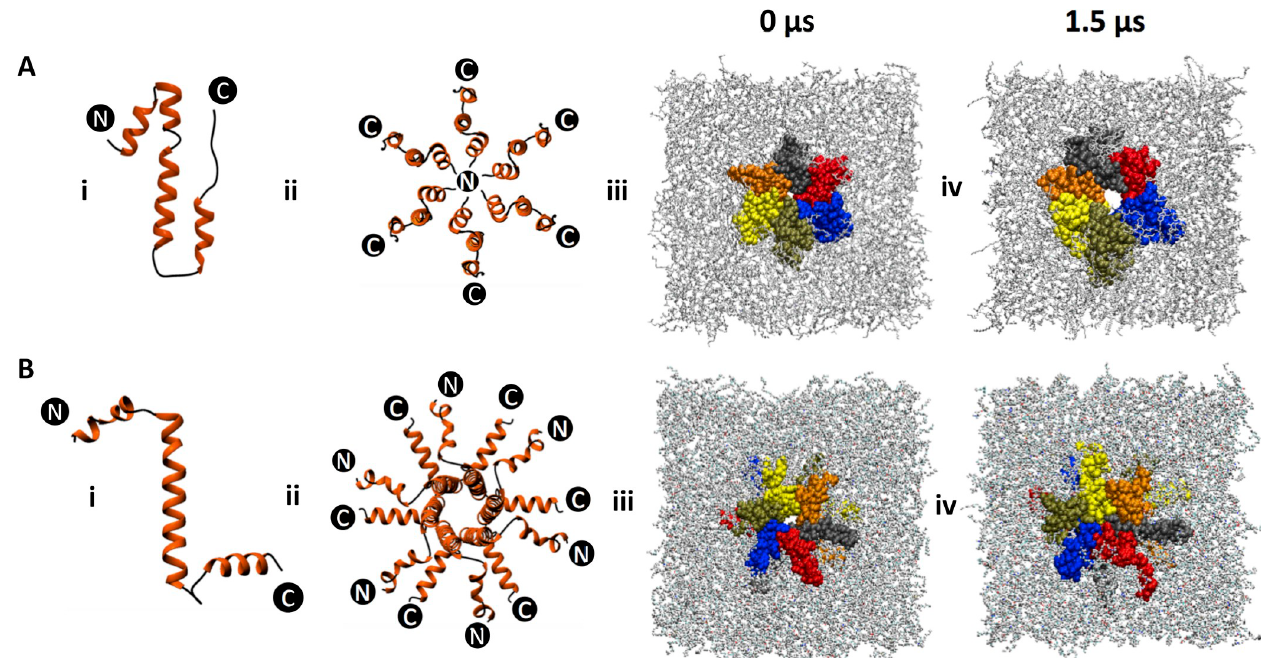
Fig 5. Molecular dynamics simulation of CHIKV 6K oligomers in membrane showing channel activity: Bhageerath-H predicted two possible predicted structures of 6K: 6k 1 (A-i) and 6k 2 (B-i) along with their respective oligomeric arrangements (A-ii and B-ii), and snapshots of micro-second scale simulations of 6K embedded within POPC membranes (A-iii, iv and B-iii, iv respectively). Membrane lipids are colored grey (line representation), while 6K monomers are color-coded from peptide1-6 (green-yellow-orange-black-red-blue) in space-filling, van der waal’s representation.